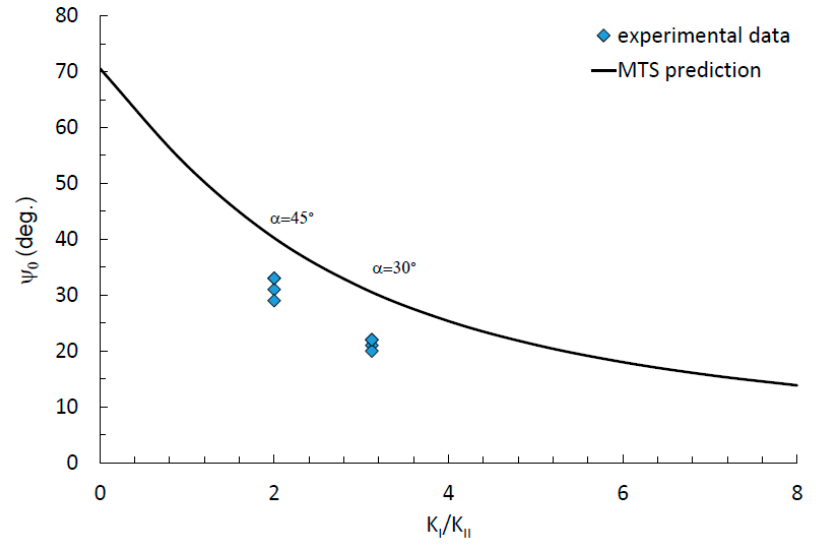
Figure 12. Crack initiation angles , according to MTS (Maximum Tangential Stress) criterion and experimental data for mode I + II.